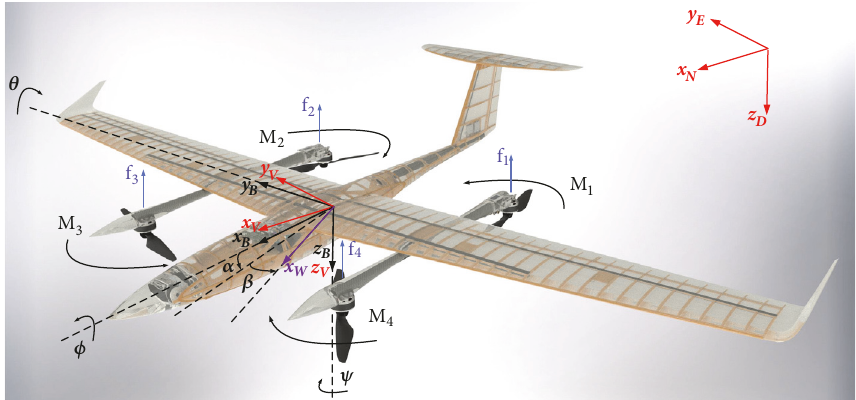
Figure 4: The final design of the VTOL